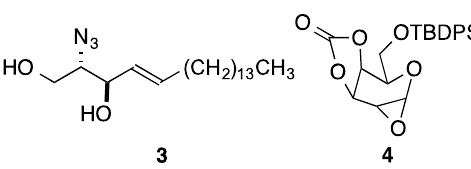
Figure 2. β -Glycosylation